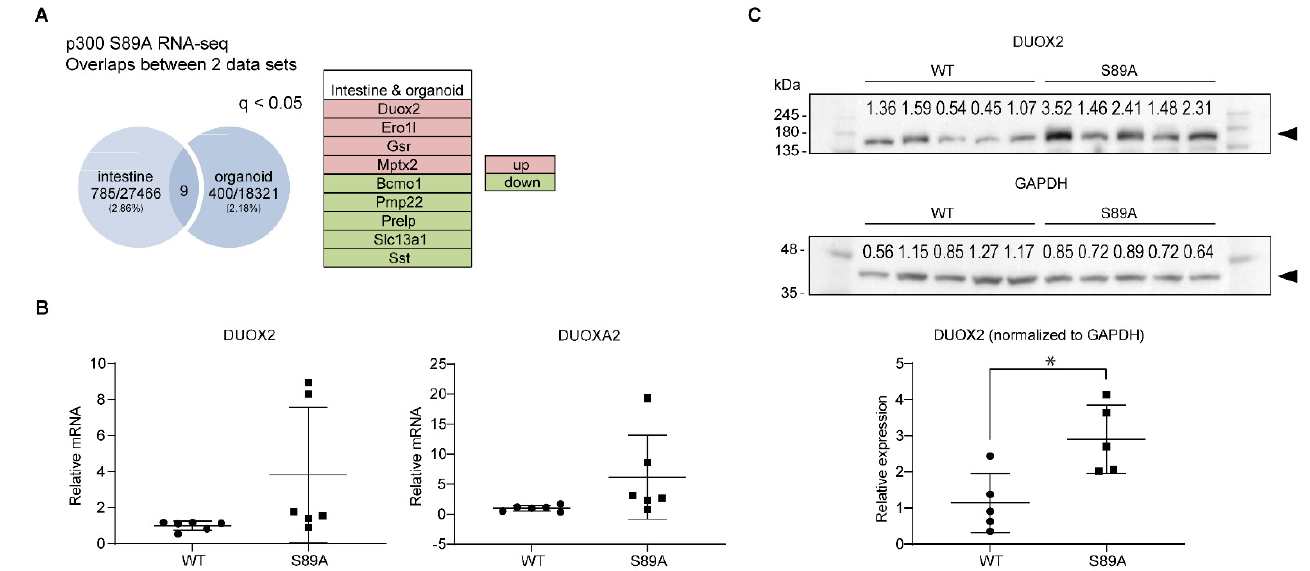
Figure 5. Genomic analysis of p300 S89A mice intestinal tissue. ( A ) RNA-seq analysis identifies 9 genes significantly differentially expressed in intestinal tissue and intestinal organoids derived from S89A mice versus those derived from WT mice. up, up-regulated; down, down-regulated. ( n = 3 per group.) ( B ) RT-qPCR analysis of Duox2 and Duoxa2 mRNA levels in intestine of S89A and WT mice. ( C ) Immunoblot analysis of Duox2 protein levels in intestinal tissue of S89A and WT mice. Numerical values above protein bands indicate densitometric quantitation. Data in graphs are mean ± s.d. ( n = 5–6 per group). * p < 0.05. Whole immunoblots corresponding to immunoblot data are included in Figure